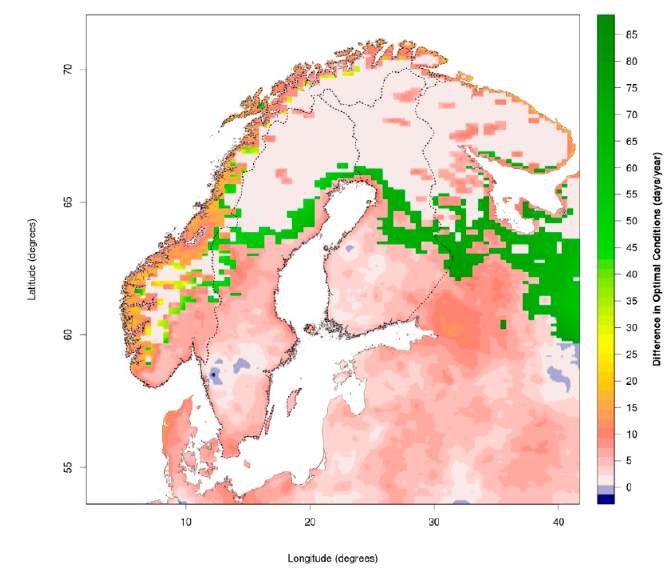
Figure 3. Di ff erence in number of days / year between past / present and future (RCP4.5) optimal Figure 3. Difference in number of days/year between past/present and future (RCP4.5) optimal climatic climatic conditions.